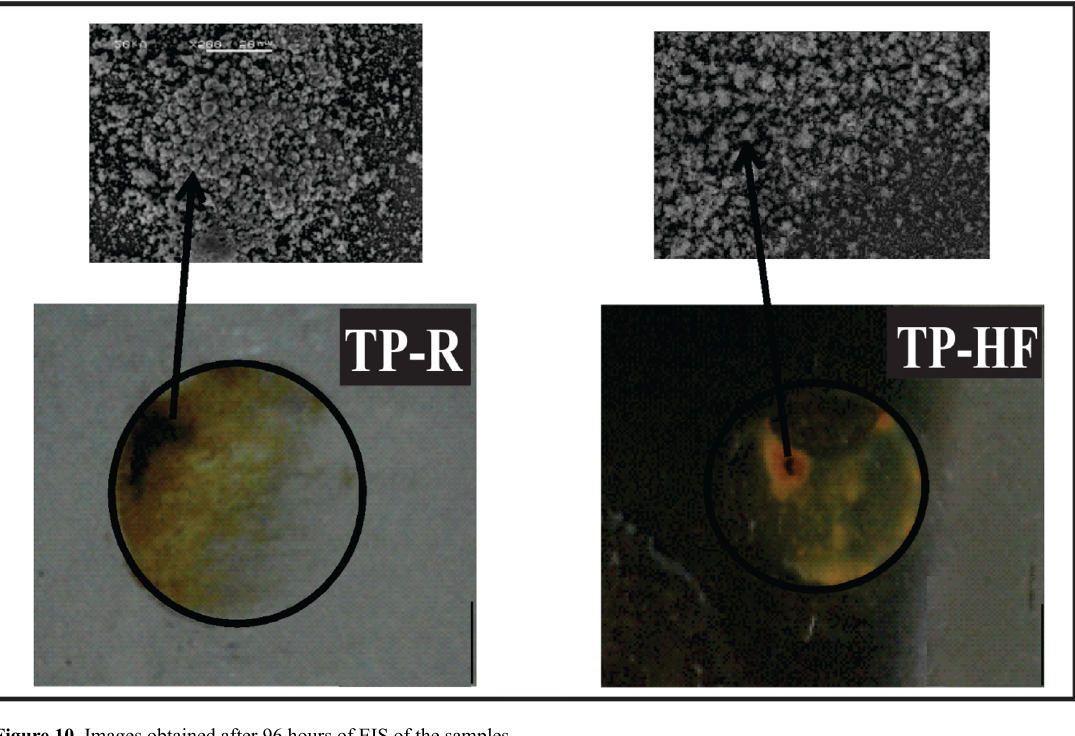
Figure 10. Images obtained after 96 hours of EIS of the